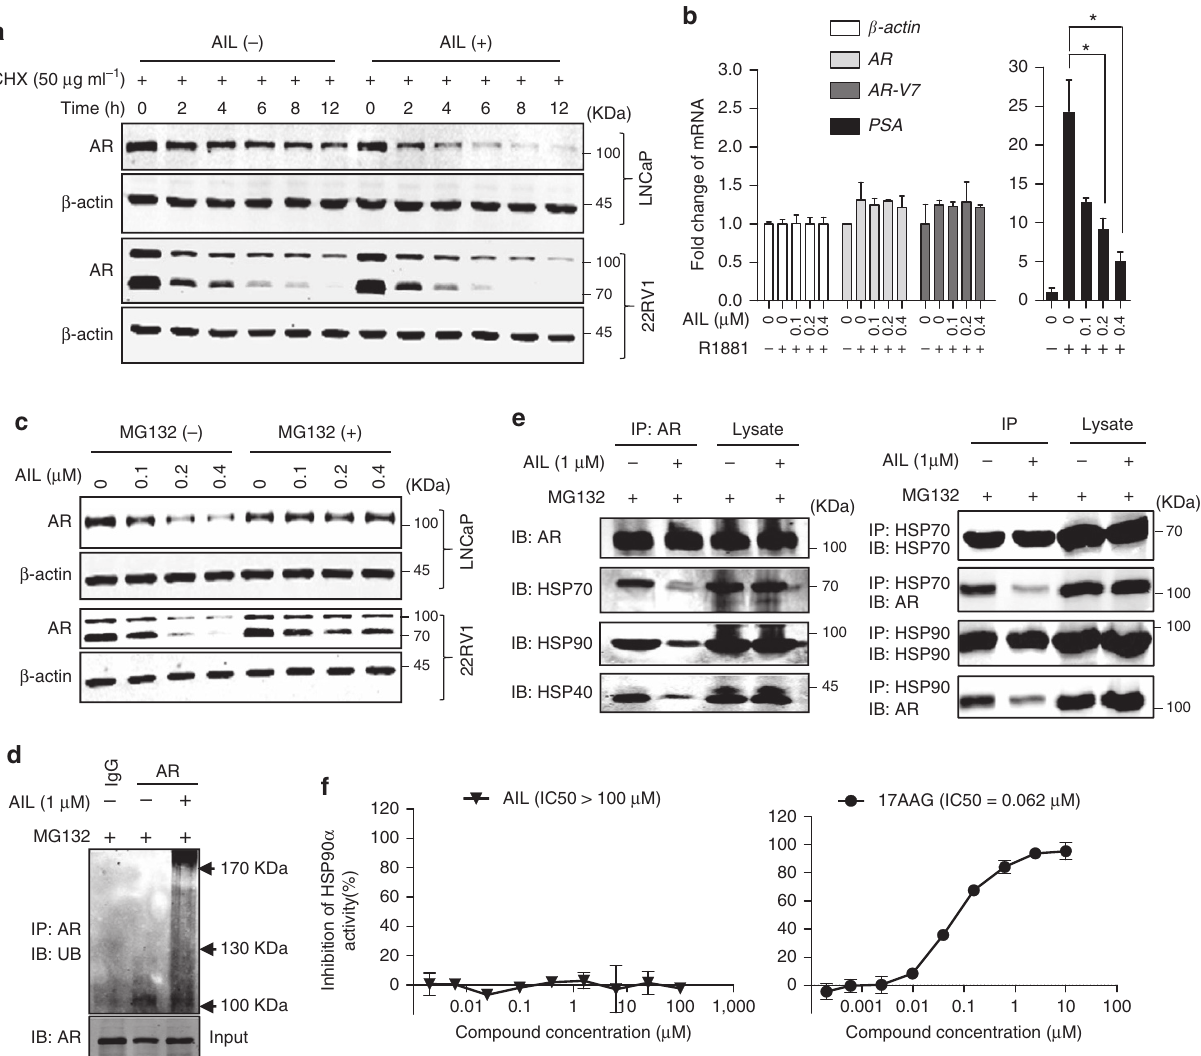
Figure 4 | Reduction of AR protein stability by AIL. ( a ) LNCaP and 22RV1 cells were treated with cycloheximide (CHX) with or without AIL for various lengths of time. AR protein level was measured by western blotting analysis. ( b ) LNCaP cells were cultured in c-FBS for 5 days and treated with AIL in the absence or presence of 10nM R1881 for 12h. Total RNA was extracted and quantitative-PCR was performed. The AR-V7 mRNA level was detected in 22RV1 cells that were treated with the indicated concentrations of AIL for 12h. The expression of AR , AR-V7 and PSA was normalized to b -actin expression. Data were expressed as mean ± s.d. of three independent assays; Student’s t -tests were performed; * P o 0.05. ( c ) LNCaP and 22RV1 cells were treated with various concentrations of AIL with or without MG132 (10 m M) and AR protein level was measured by western blotting analysis. ( d ) Immunoprecipitation (IP) was done using anti-AR and immunoblotting performed with an anti-ubiquitin antibody. Input: immunoblot of lysates probed with AR antibody. ( e ) 22RV1 cells were treated with or without AIL in the presence of MG132. IP was done using anti-AR, anti-HSP90 and anti-HSP70 antibodies